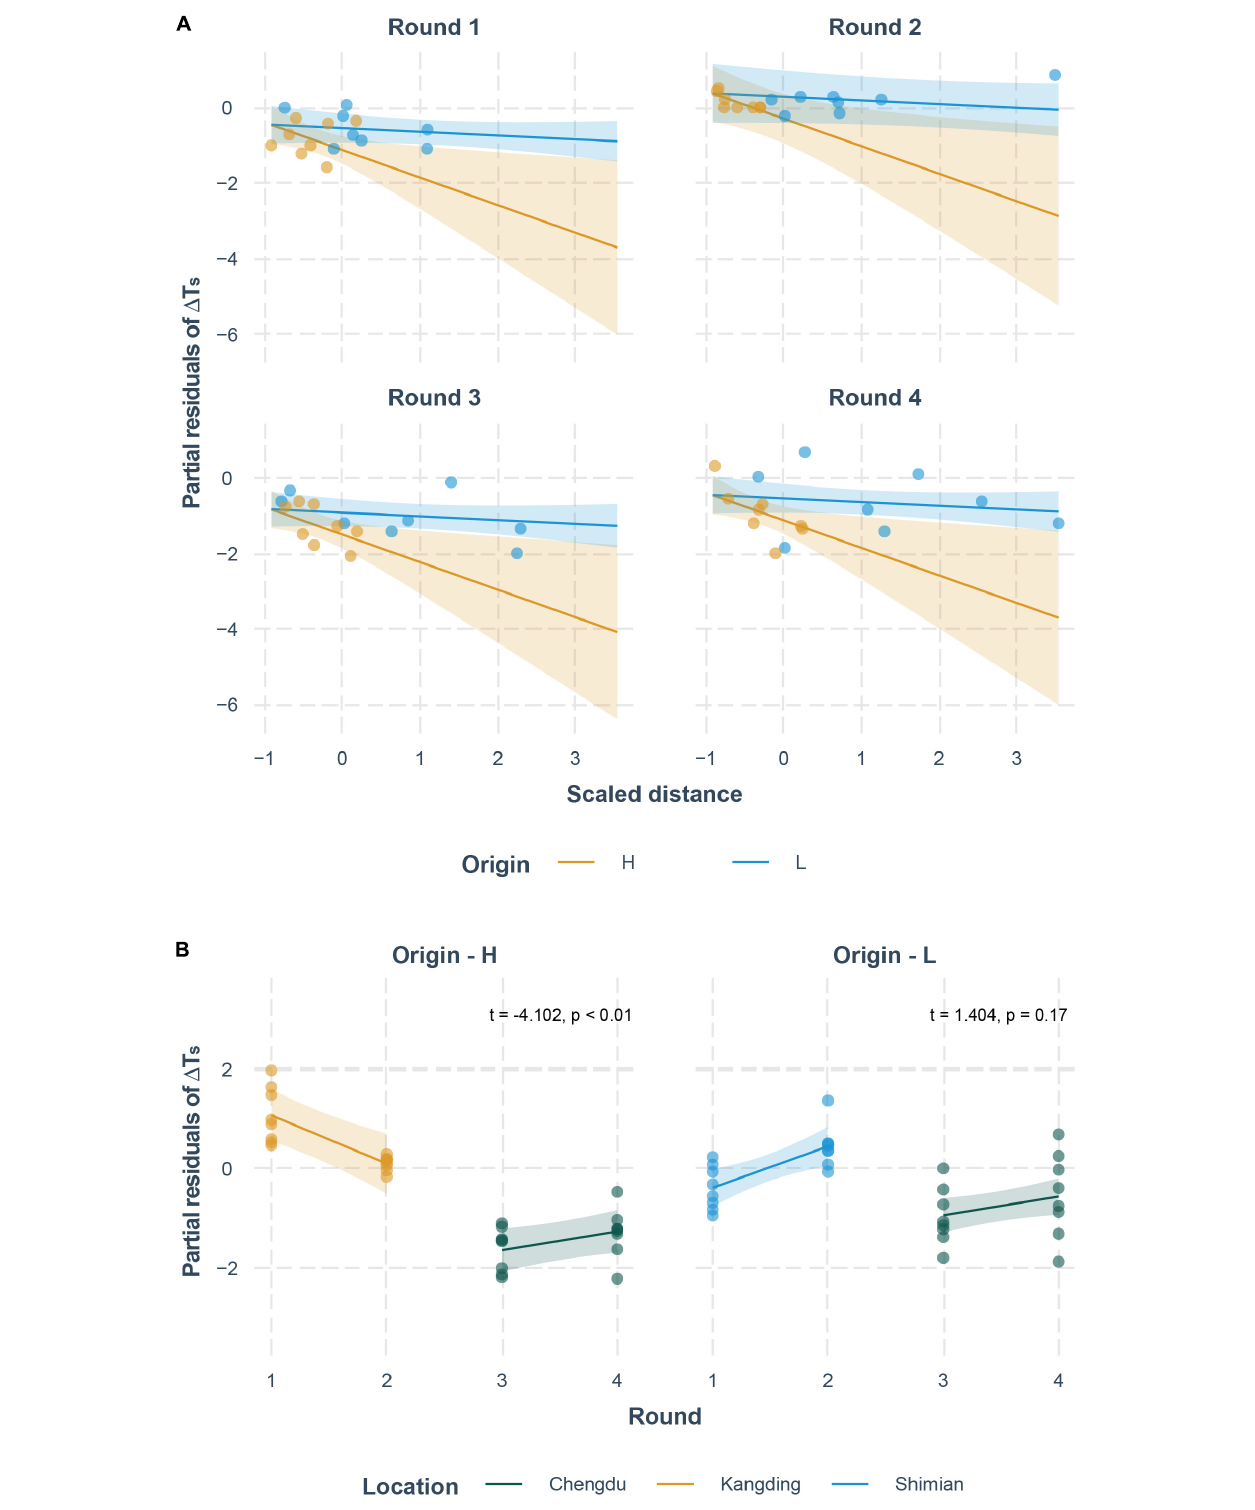
FIGURE 3 | Correlation between interactive effects and (cid:49) T S . (A) Interactive effect of distance and origin on (cid:49) T S . (B) Interactive effect of round and location on (cid:49) T S . The partial residuals of (cid:49) T S are plotted after controlling for effects of all controlled variables.